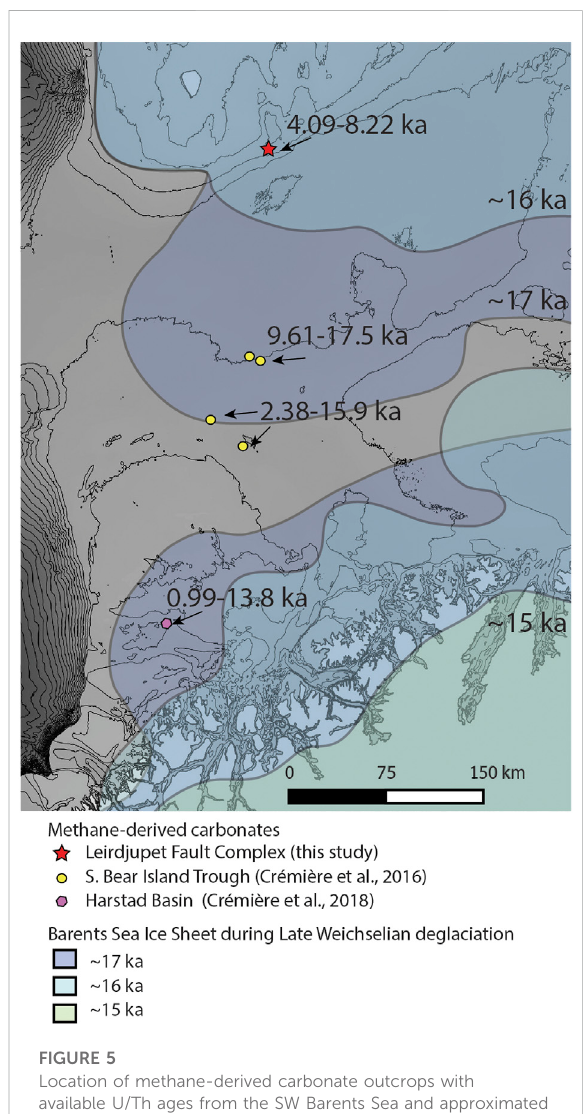
FIGURE 5 Location of methane-derived carbonate outcrops with available U/Th ages from the SW Barents Sea and approximated positions of the retreating ice-front at different stages of deglaciation of the Barents Sea Ice Sheet after Winsborrow et al.,